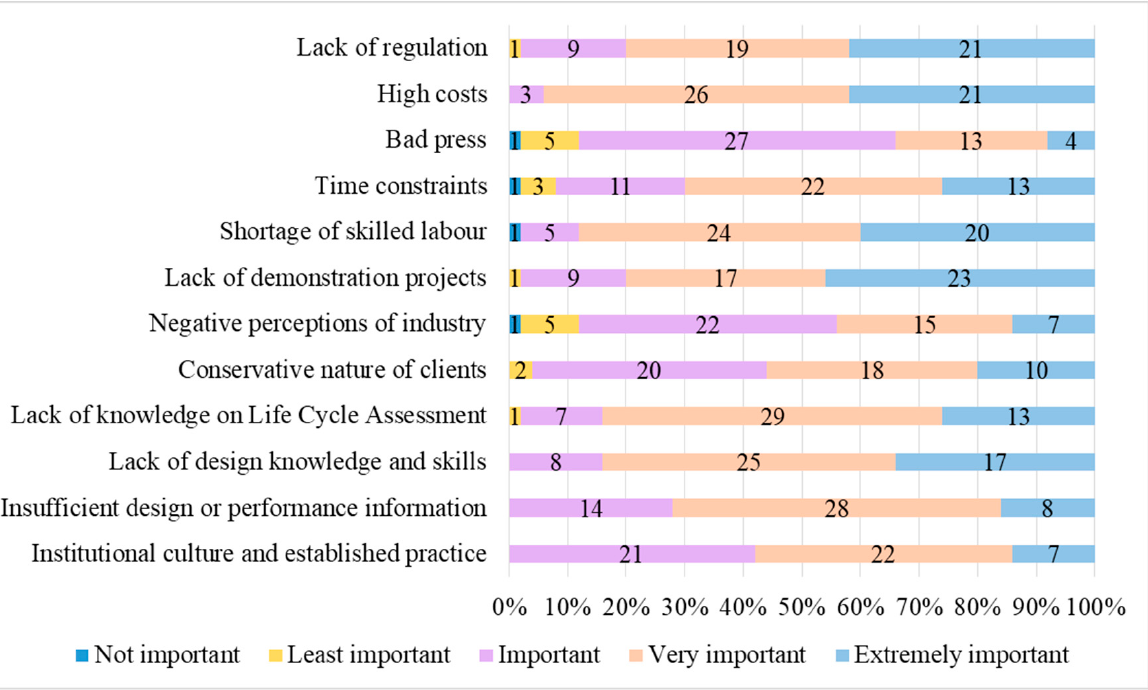
Figure 4. Barriers to the selection of alternative materials.